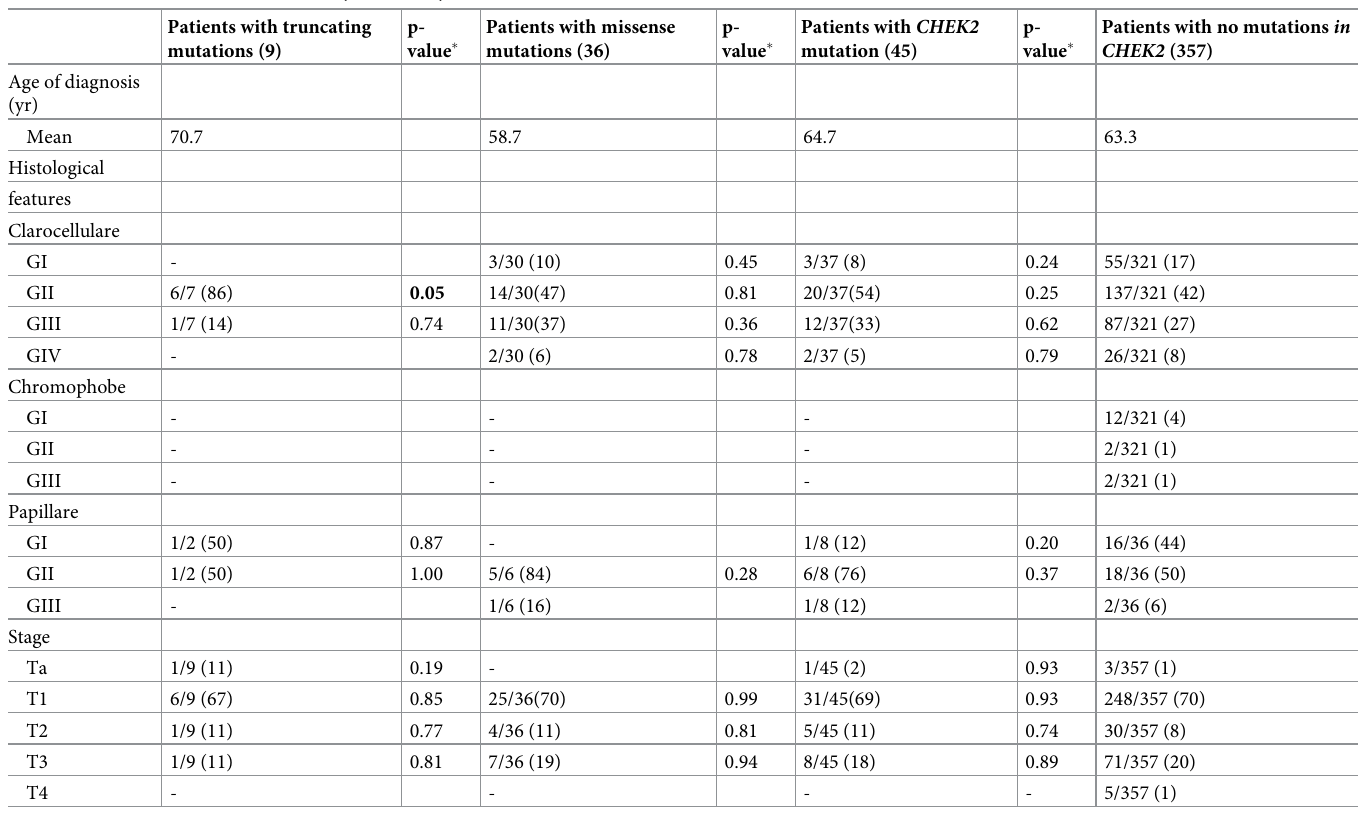
Table 5. Clinical characteristics of kidney cancers; by variant alleles of CHEK2 . Patients with truncating mutations